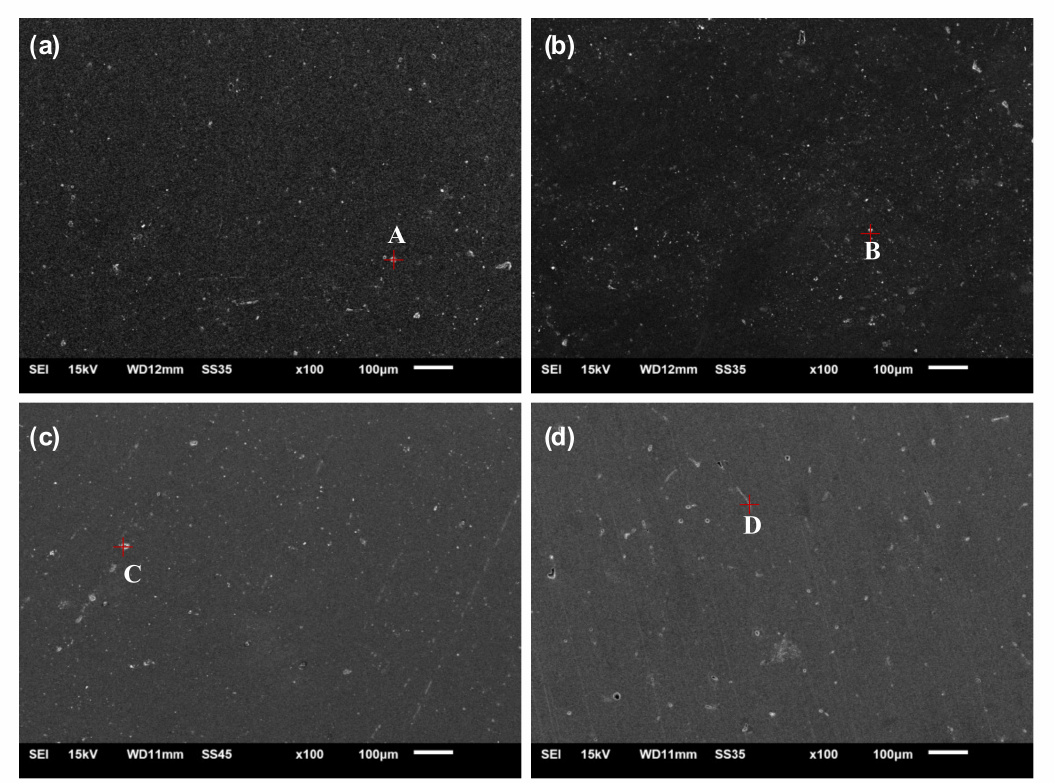
Figure 2. SEM images of the Al-1Zn-0.1In-0.1Sn-0.5Mg-xMn alloys: ( a ) x = 0, ( b ) x = 0.1, ( c ) x = 0.2, ( d ) x = 0.3. Table 2. The composition measurements of the segregated phases of the as-cast Al-1Zn-0.1In-0.1Sn-